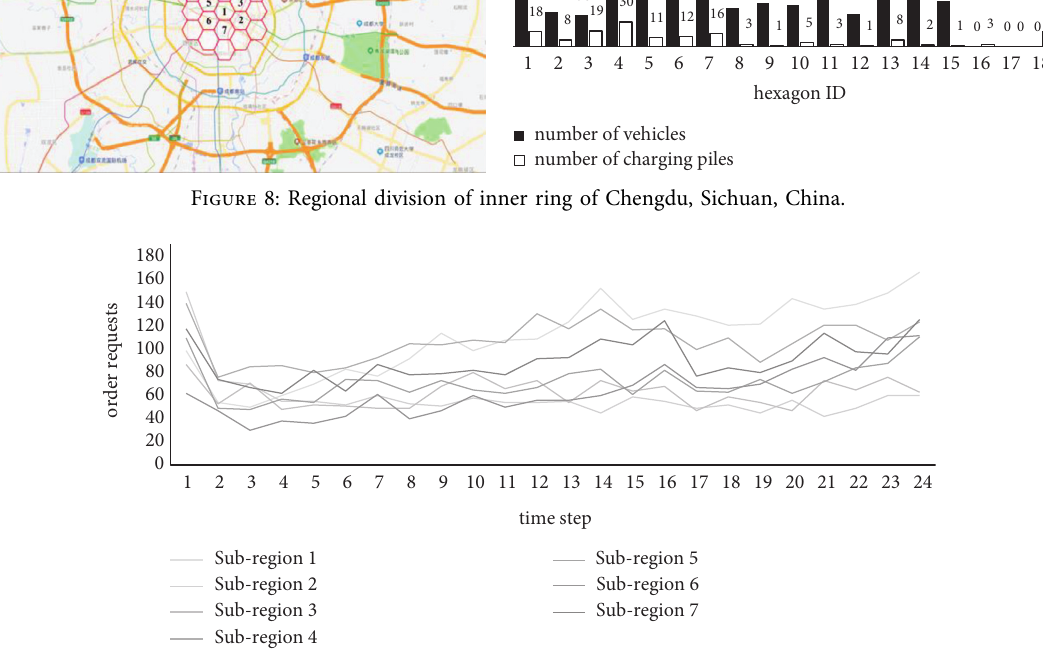
Figure 9: Fleet and charging piles initialization configuration among 19